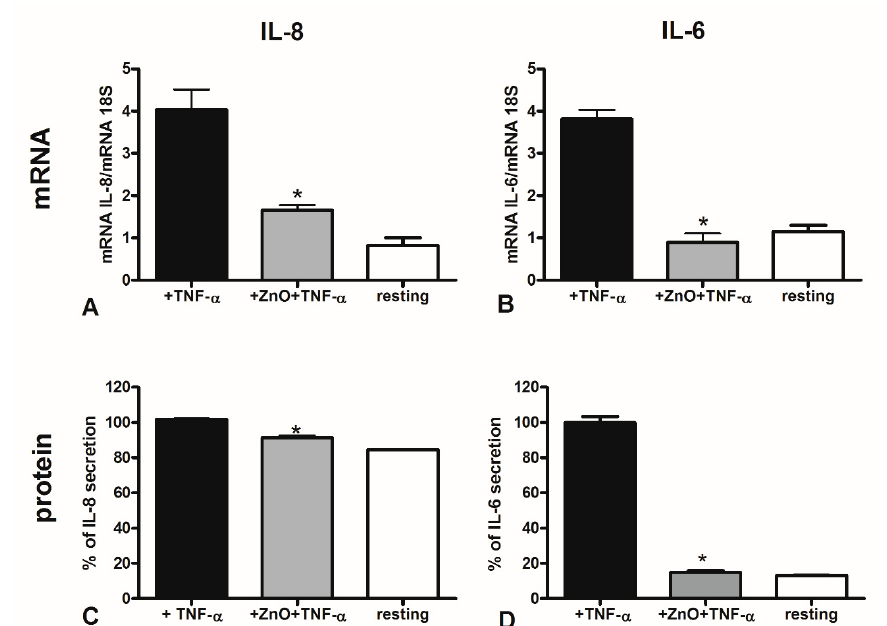
Figure 4. Expression of pro-inflammatory cytokines by DECs treated with zinc oxide (ZnO). RT-qPCR analysis for the expression of IL-8 ( A ) and IL-6 ( B ) highlighted a decreased mRNA expression of cytokines after treating the cells with ZnO and TNF- α , as compared to untreated cells ( + TNF- α only). Data represent the mean ± S.E.M. of three di ff erent DEC populations. * p < 0.05 vs. Untreated (Mann-Whitney test). ELISA assays for the protein measurement of IL-8 ( C ) and IL-6 ( D ) in DECs’ supernatant highlighted a decreased protein expression level of cytokines after treating the cells with ZnO and TNF- α , as compared to untreated cells ( + TNF- α only). Data represent the mean ± S.E.M. of three di ff erent DEC populations. * p < 0.05 vs. Untreated (Mann-Whitney